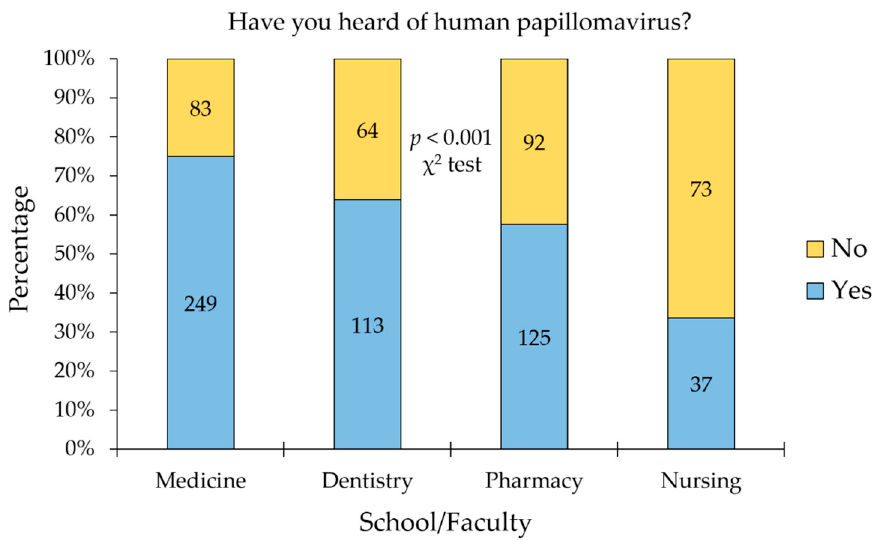
Figure 1. The prior knowledge of human papillomavirus among the study participants per school/faculty. The p value was calculated using the chi-squared ( χ 2 ) test.